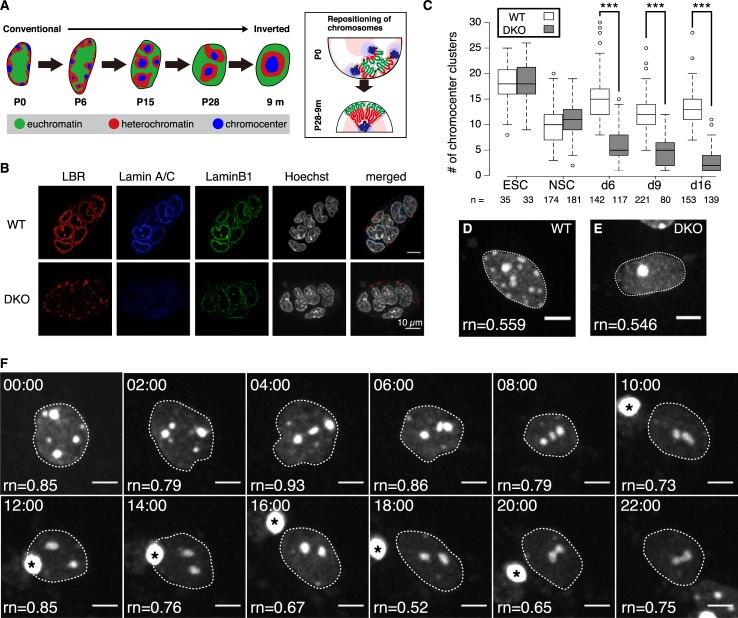
Experimental model cell system for nuclear architecture reorganization.(A) Mouse rod photoreceptor cells at 0, 6, 15 and 28 days after birth and 9 months after birth (P6, P15, P28, and 9 m respectively). The right panel diagram shows chromosome repositioning during the nuclear architecture reorganization. (B) An immunofluorescence assay showing expression of LBR, LamA/C, and lamin B1 in wild-type (WT) and double-knockout (DKO) cells. Scale bar: 10 μm. (C) The number of chromocenter (CC) clusters during differentiation. *, statistical difference by the Student's t-test: ***P < 10−10. (D, E) Fluorescence images of the nuclei of WT and DKO cells at 16 days post-differentiation. The values of roundness (rn) of each nuclei are shown. (F) Time-lapse microscopy of DKO cells 3 days post-differentiation at 30 min intervals for 44 h (S1–S3 Movies). Asterisks represent cellular debris. The values of roundness (rn) of each time frame are shown. The dotted curves in panels (D–E), (F) identify the nuclear edge. Scale bars: 5 μm.